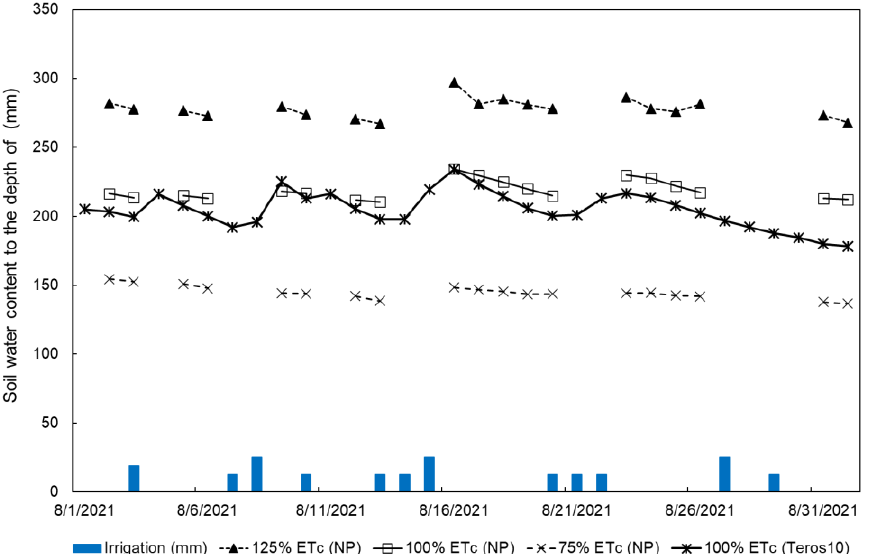
Figure 3. Monitoring soil water content throughout the August 2021 by a neutron probe at three irrigation levels 75% ET c , 100% ET c , and 125% ET c and a continuous measurement of VWC by the TEROS10 sensors.